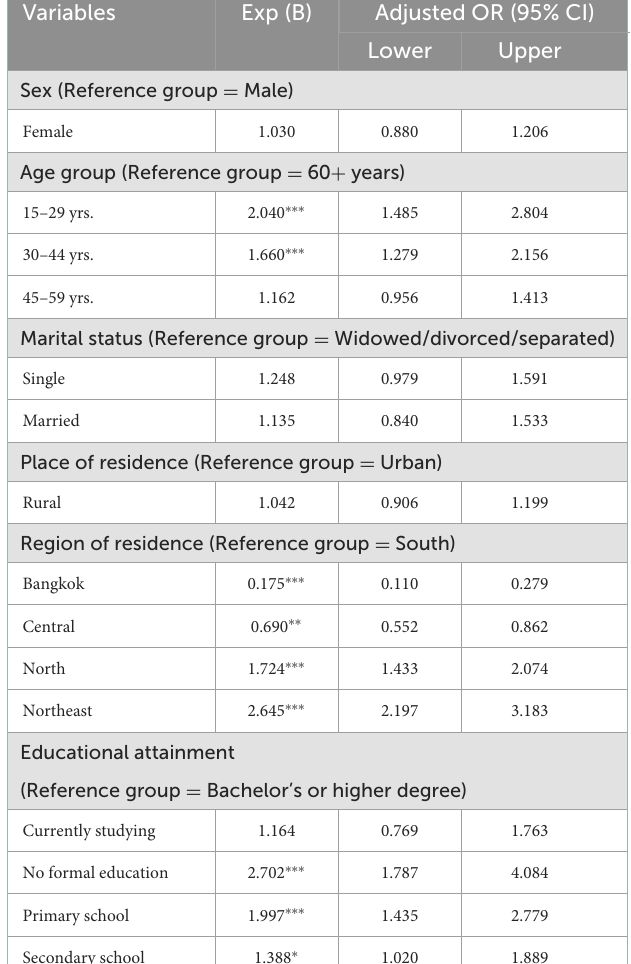
TABLE 3 Sample characteristics and food insecurity ( N =